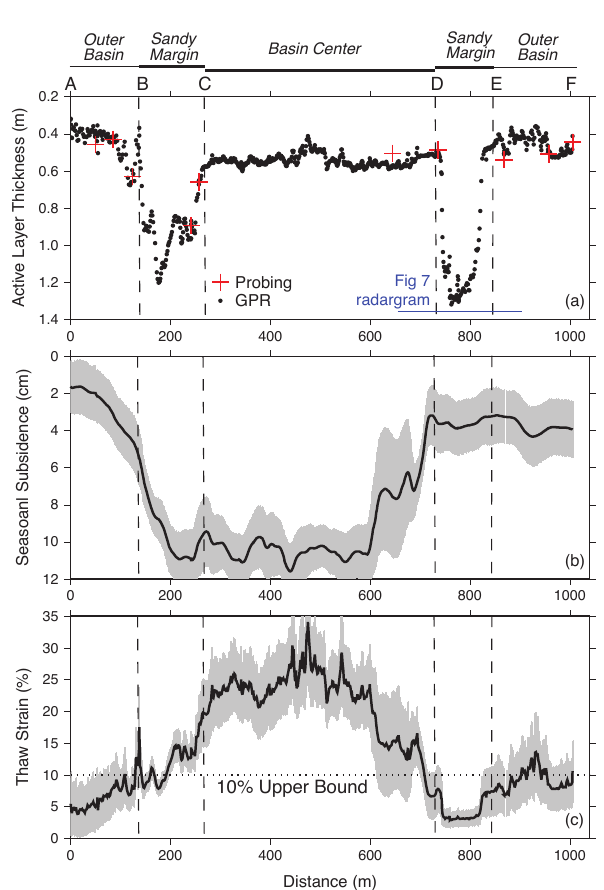
Fig. 6. (a) Active layer thickness along the Fig. 1a transect, esti- mated from probing (crosses) and GPR (dots). The uncertainties of the in situ and GPR ALT are 5cm and 6cm, respectively, but are not shown. The blue horizontal bar marks the extent of the radargram shown in Fig. 7. (b) Profile of the seasonal subsidence based on In- SAR measurements, with the uncertainties shown in gray. (c) Profile of the thaw strain, with the uncertainties shown in gray. The hori- zontal dotted line marks the upper bound for a closed